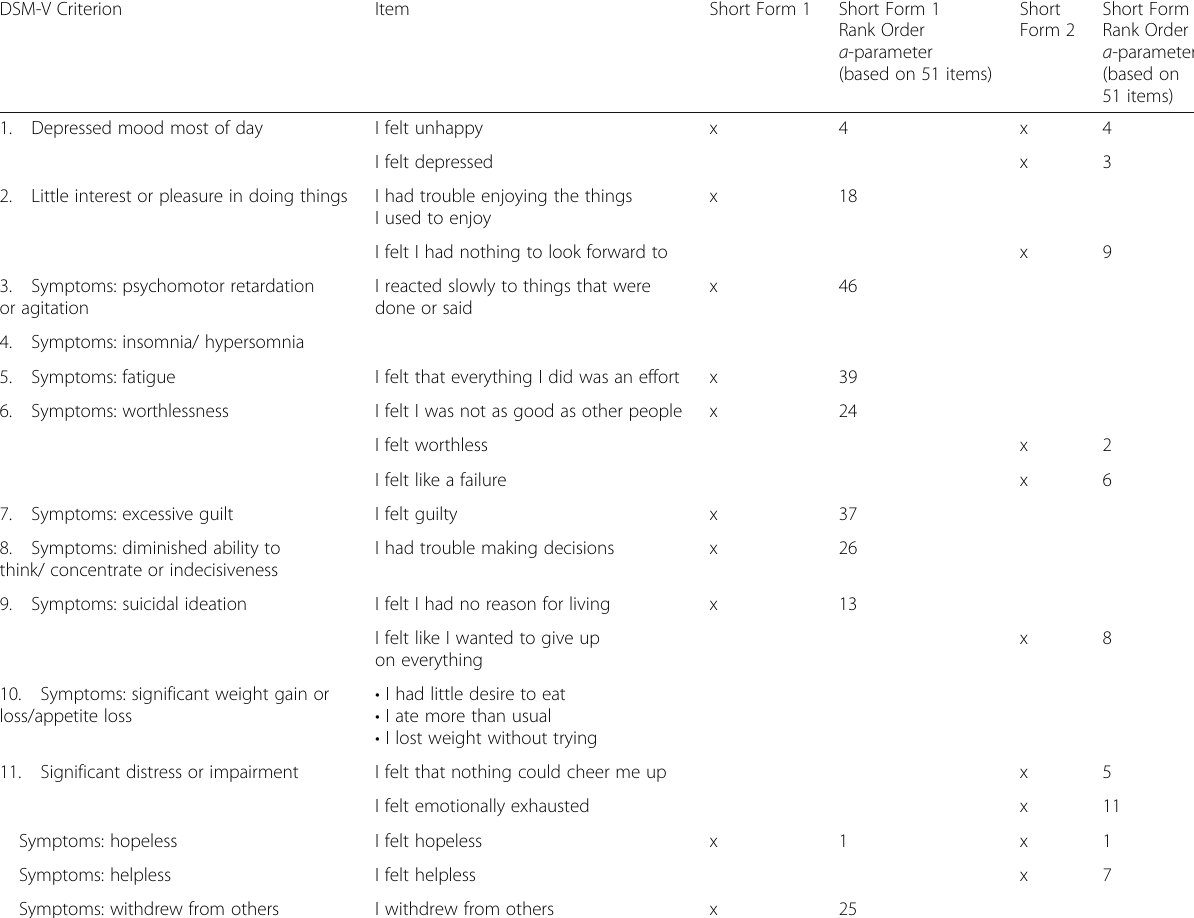
Table 3 Comparison of two potential short forms selected through a combination of psychometric properties and content validity